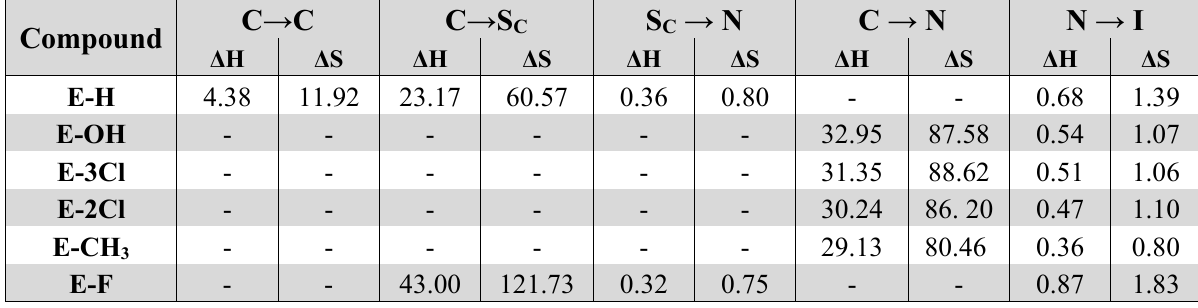
Table 2. The enthalpy and entropy values for the phase transitions of compounds.